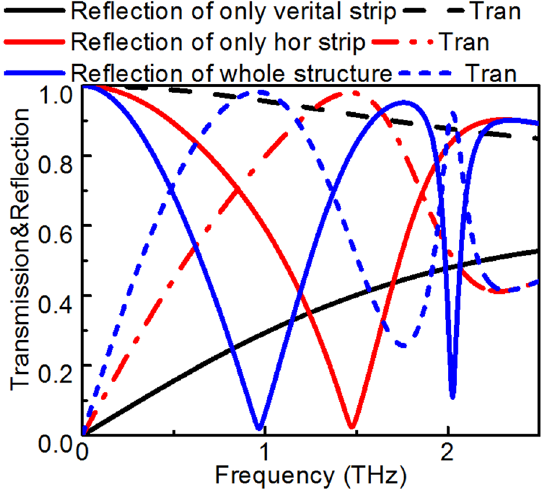
Figure 4. The variation with reflection and transmission spectra with different structure.